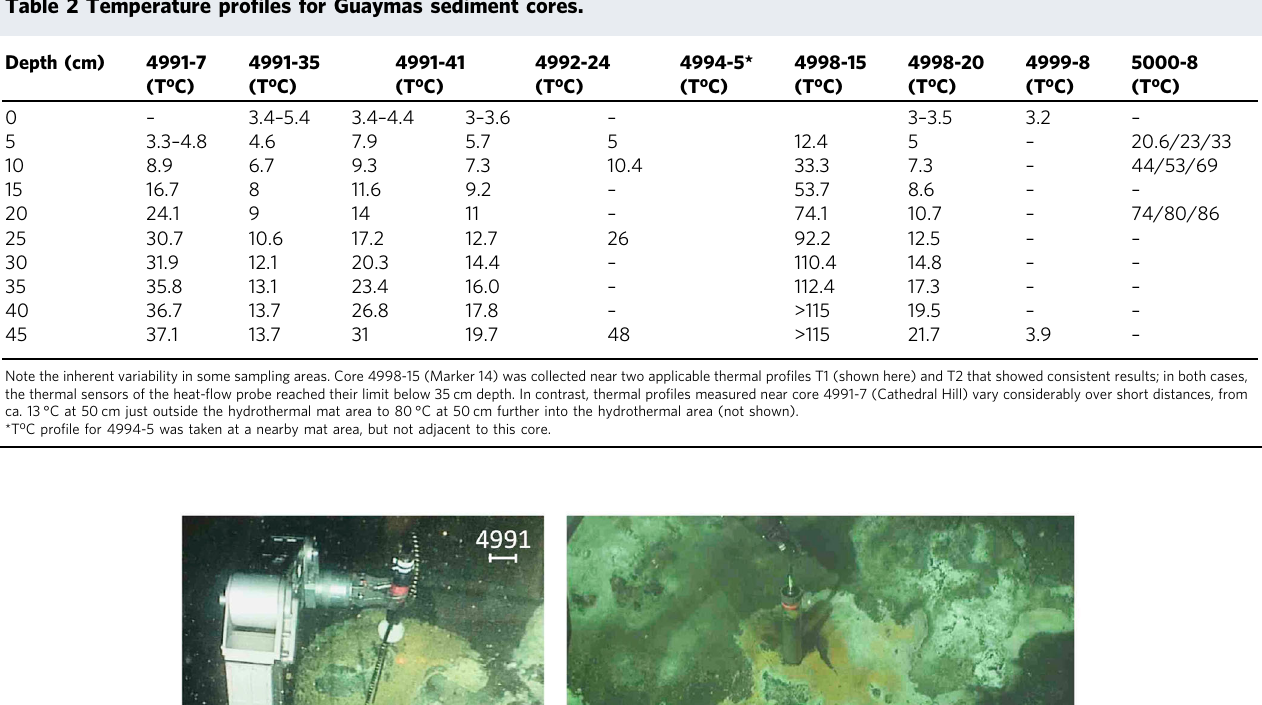
Table 2 Temperature pro fi les for Guaymas sediment cores.